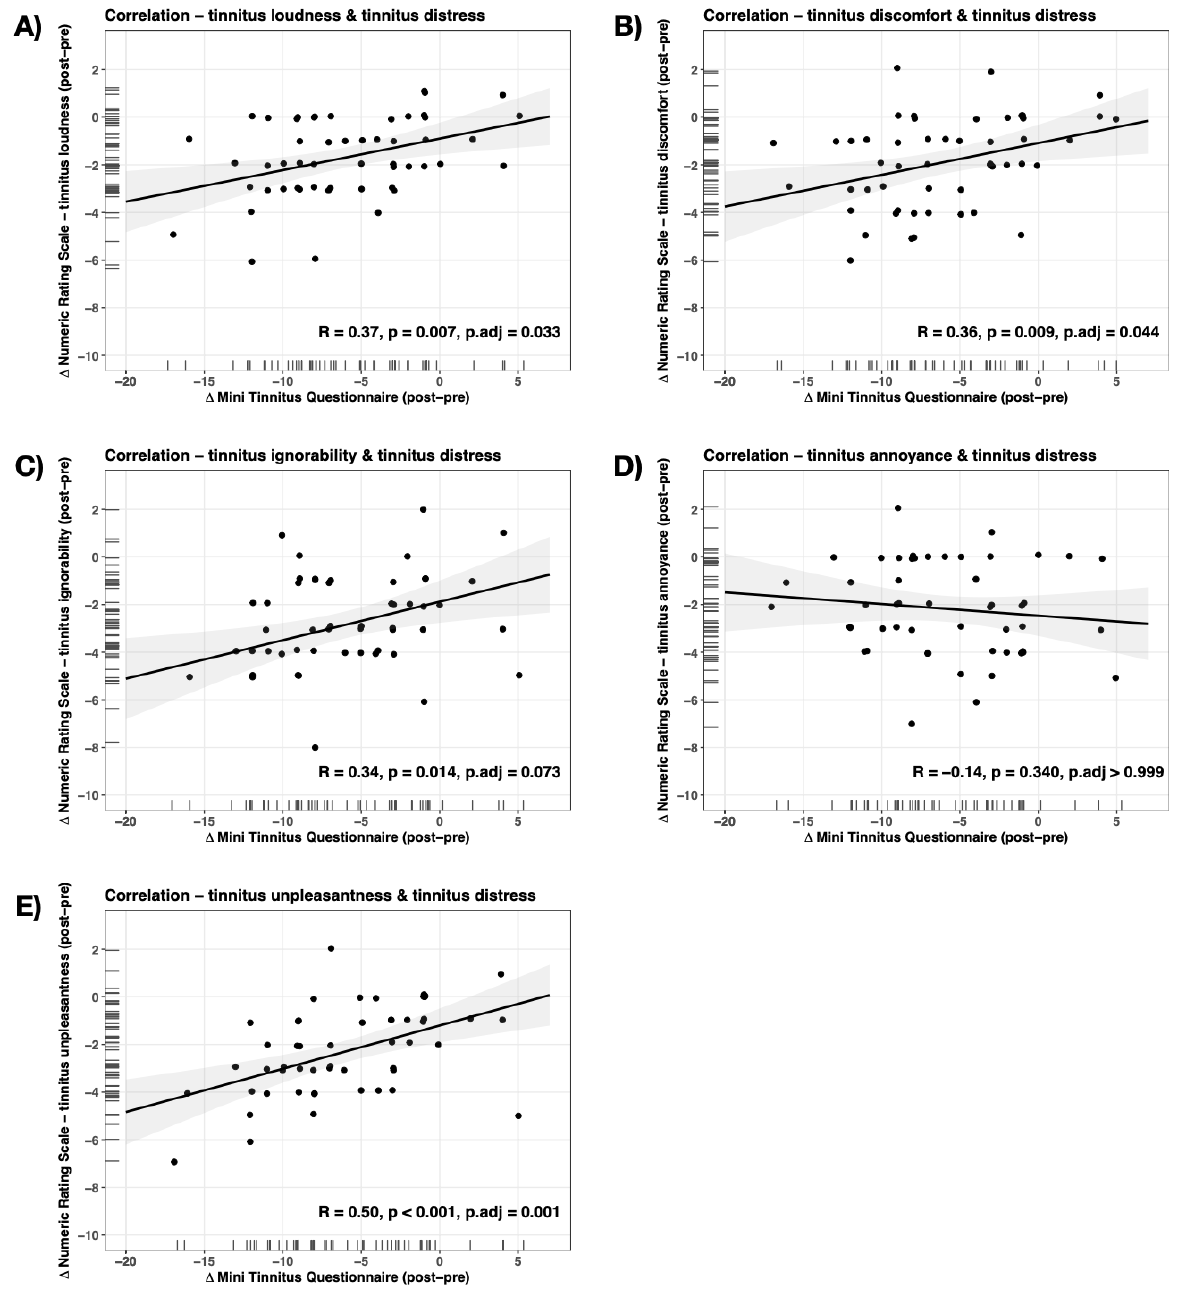
Figure 3. Correlation of changes from baseline to end of treatment of tinnitus distress with numeric ratings scales.